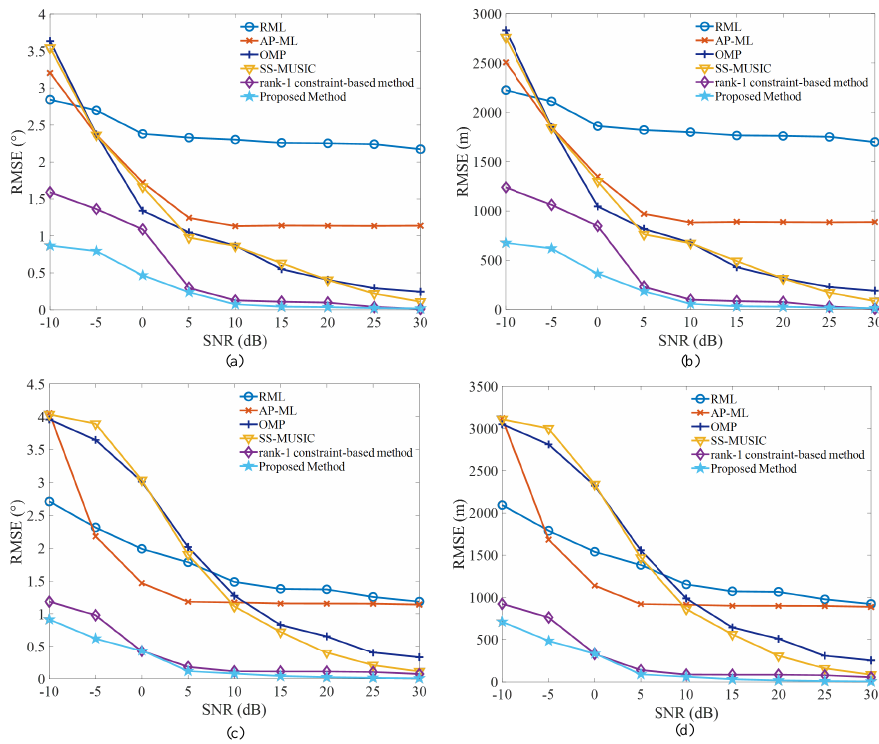
Figure 3. Comparison of RMSE results in terms of target location parameter estimates under the multipath environment involving two targets with three coherent interference paths. ( a ) Direction estimate of the target with h 1 = 5 km. ( b ) Height estimate of the target with h 1 = 5 km. ( c ) Direction estimate for the target with h 2 = 7 km. ( d ) Height estimate for the second target with h 2 = 7